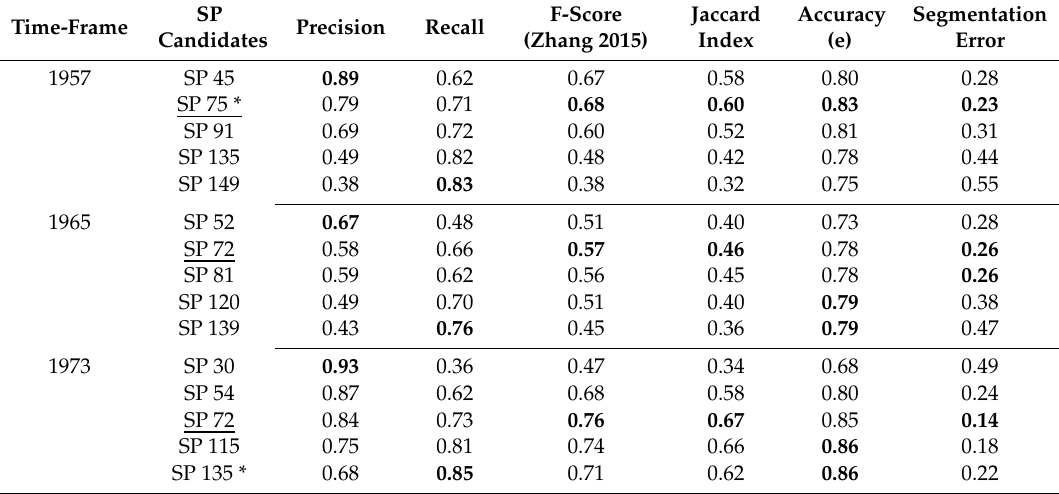
TableA2. Thesegmentationgoodnessmetrics(theoptimalSPisunderlined,thebestresultsofsegmentation goodness metrics are in bold, the SP values proposed by ESP2 at level 1 are marked with an asterisk).